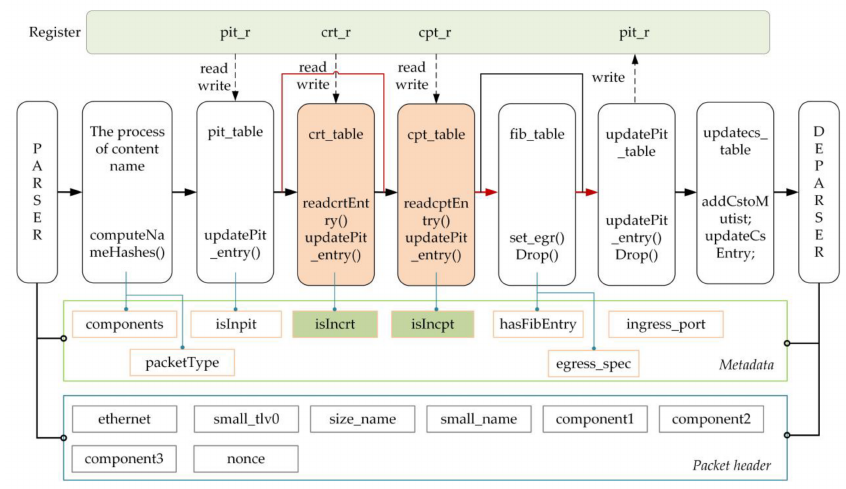
Figure 1. Control flow of the ingress pipeline.